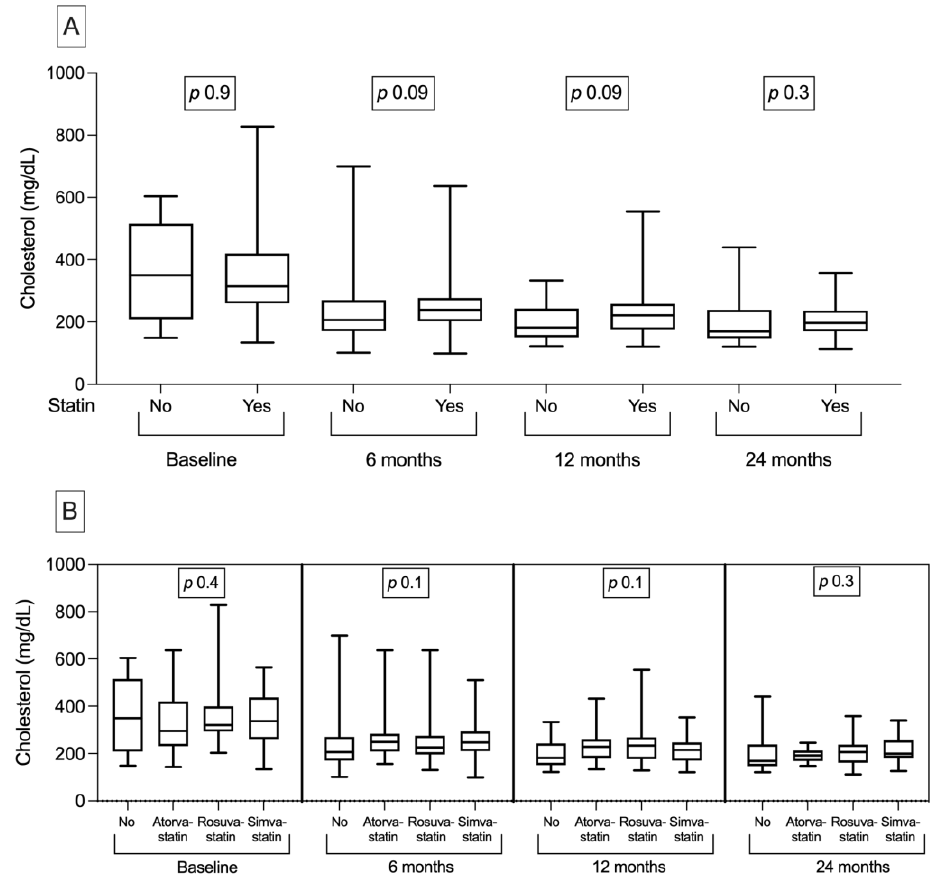
Figure 1. Cholesterol levels according to statin therapy at baseline, 6 months, 12 months, and 24 months; ( A ) statin versus no statin therapy, ( B ) types of statins used versu no statin. Overall, 79% of the studied patients reached a form of remission (Table 1). Complete remission rates were 43% after 6 months, 55% after 12 months, and 65% after 24 months. The mean time to cumulative remission was 13.7 (95%CI 12.2, 15.2) months. There was no relationship between statin therapy and time to remission (statin, 13.9 (95%CI 12.4, 15.6), no statin, 12.6 (95%CI 8.8, 16.3) months, p 0.4) (Figure 2A).